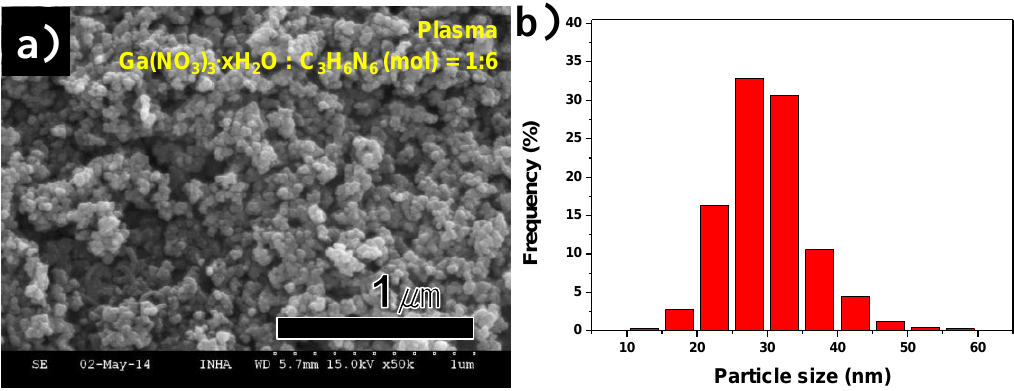
Figure 10. ( a ) FE-SEM image and ( b ) size distribution of synthesized GaN nanopowder after annealing in Plasma 3.